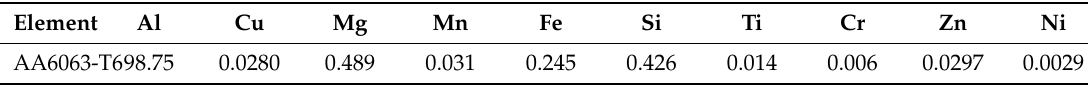
Table 1. Chemical composition of AA6063-T6.